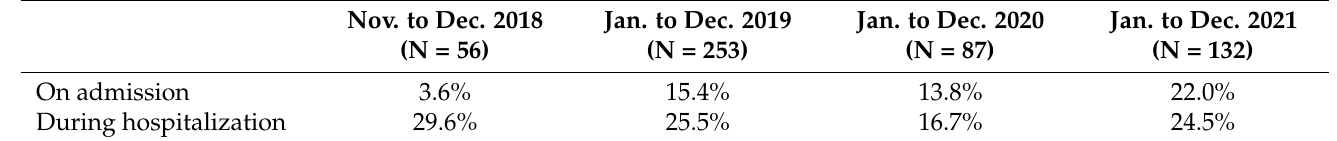
Table 5. Prevalence of CRE fecal carriage of the enrolled patients upon admission and during